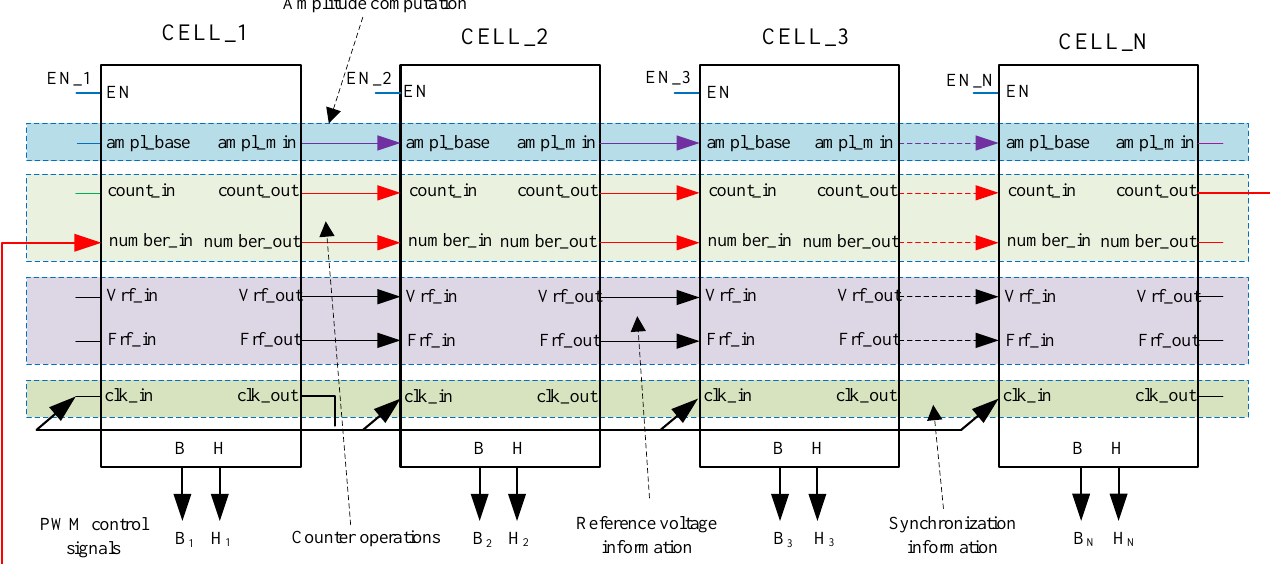
Figure 7. Connection between each cell controller with the proposed decentralized self-aligned level-shifted carriers (DSA-LSC) method. Table 2. Input and output of cell controller with DSA-LSC method.